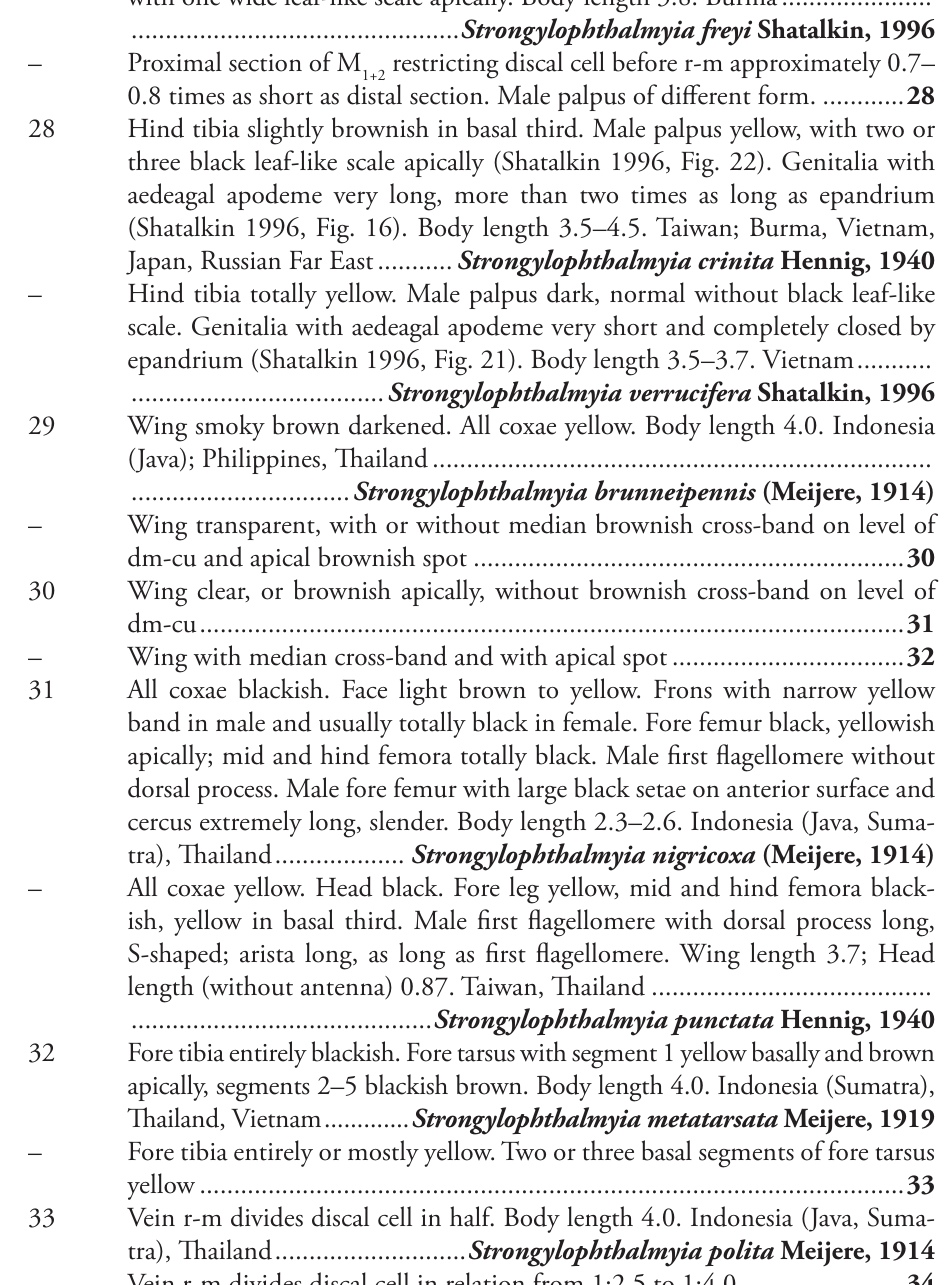
– Proximal section of M restricting discal cell before r-m approximately 0.7– 1+2 0.8 times as short as distal section. Male palpus of different form. ............ 28 28 Hind tibia slightly brownish in basal third. Male palpus yellow, with two or three black leaf-like scale apically (Shatalkin 1996, Fig. 22). Genitalia with aedeagal apodeme very long, more than two times as long as epandrium (Shatalkin 1996, Fig. 16). Body length 3.5–4.5. Taiwan; Burma, Vietnam, Japan, Russian Far East ........... Strongylophthalmyia crinita Hennig, 1940 – Hind tibia totally yellow. Male palpus dark, normal without black leaf-like scale. Genitalia with aedeagal apodeme very short and completely closed by epandrium (Shatalkin 1996, Fig. 21). Body length 3.5–3.7. Vietnam ........... 29 Wing smoky brown darkened. All coxae yellow. Body length 4.0. Indonesia